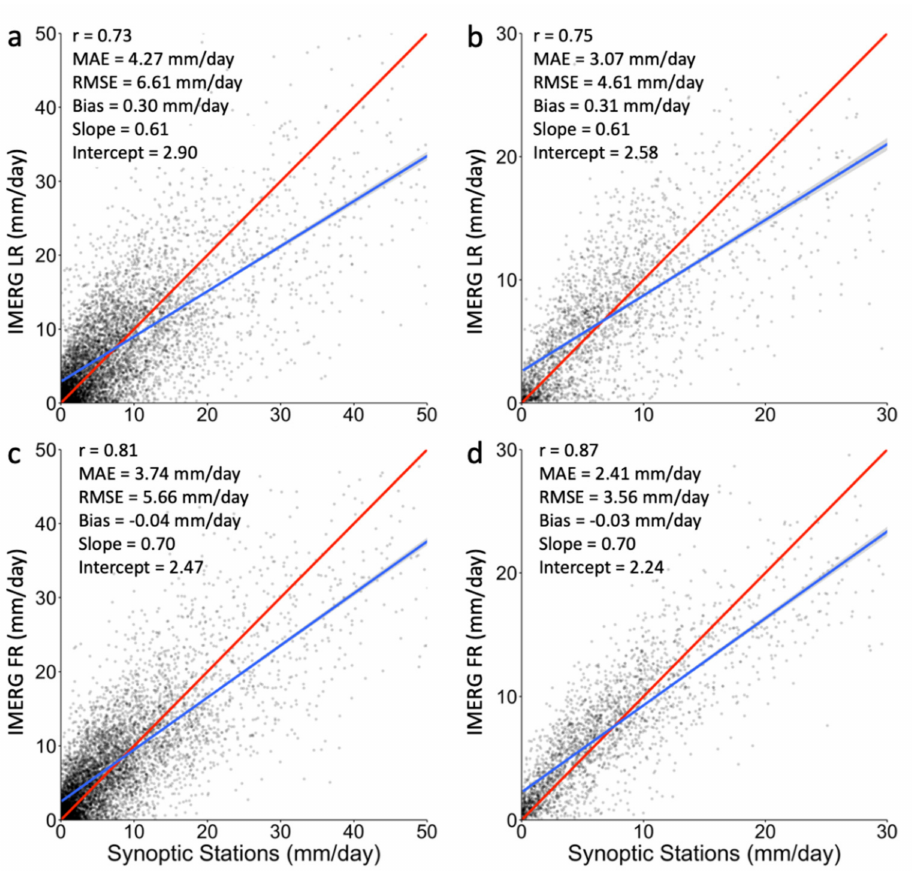
Figure 3. Synoptic rainfall measurements compared with IMERG LR at the ( a ) 10 day and ( b ) monthly scale. Plots ( c , d ) are counterpart comparisons using IMERG FR. The red line depicts perfect agreement rainfall values and the blue line indicates the linear regression fit to the data points.